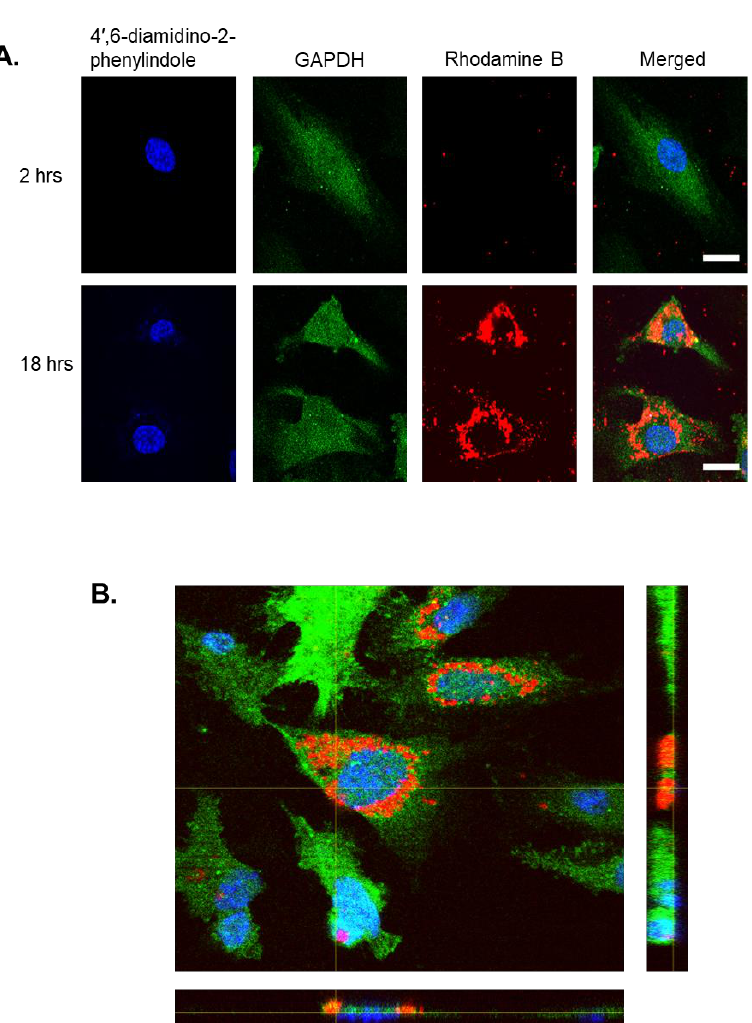
Figure 3. Rhodamine B-loaded PLGA RG-503H nanoparticles internalise into human endothelial cells. ( A ) Human endothelial cells were incubated over 18 hrs (hours) with Rhodamine B-loaded PLGA RG-503H nanoparticles to assess their ability to internalise. Cells were labelled with a GAPDH 14C10 monoclonal antibody for cytoplasm staining, 4′,6 -diamidino-2-phenylindole for nucleus staining and Rhodamine B fluorescent dye for nanoparticle staining. Nanoparticles were found to accumulate within the cytoplasm after 18 hrs. Cells were visualised using Zeiss Axio Observer Z1 immunofluorescence microscope. Representative images of each channel alongside a merged image are shown with scale bar = 10 µM. ( B ) Z-stack images showing localisation of nano- particles within endothelial cells. Both angles confirm nanoparticles have internalised and do not aggregate or clump on the cell exterior. Blank nanoparticles were prepared using the base formulation parameters in three independent batches with average size of 339 ± 12 nm. The average PDI was less than 0.3 and therefore the samples were considered to be monodispersed. Largely negative zeta potentials ( − 31.73 ± 2.4 mV) were obtained in all batches which highly favour nanoparticle stability by preventing particle aggregation.